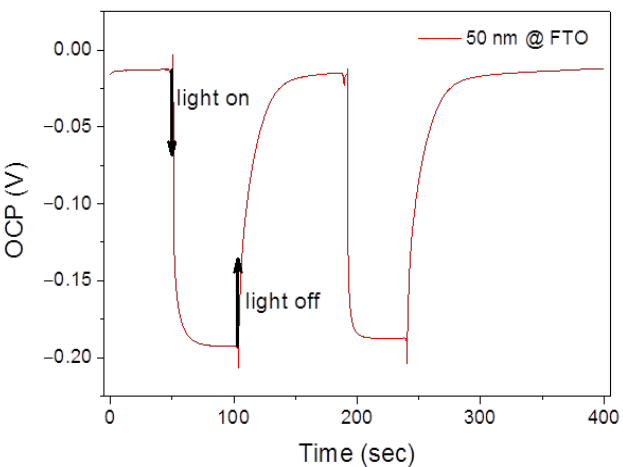
Figure 6. Changes in the open-circuit potentials over time when turning the light source on and off.